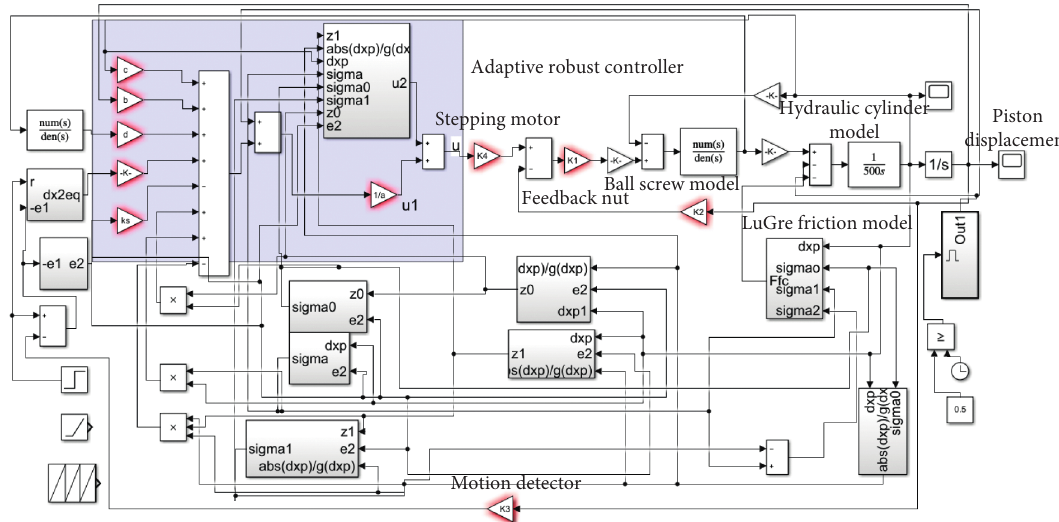
Figure 3: Simulation program of adaptive friction compensation control.